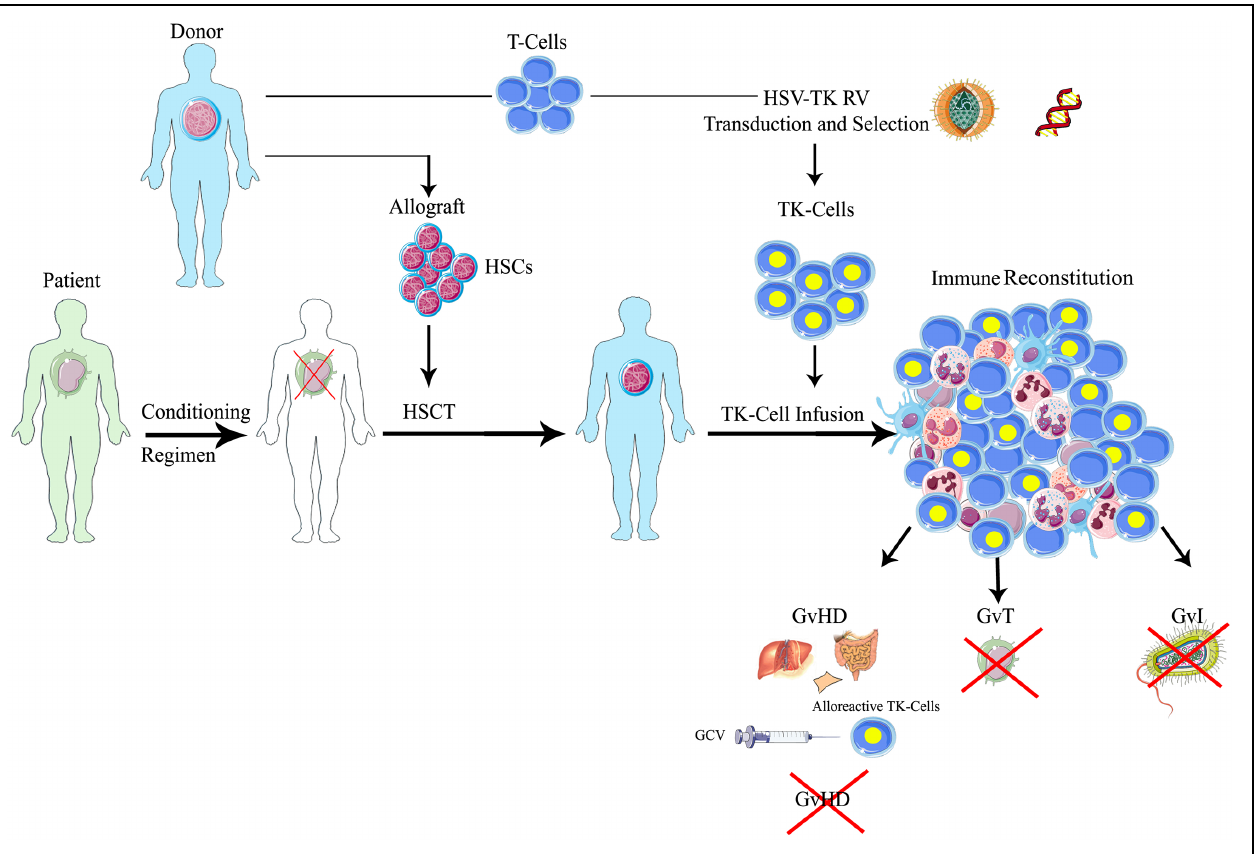
FIGURE 1 | Schematic representation of suicide gene therapy in allogeneic HSCT. Patients affected by hematologic malignancies, after a myeloablative conditioning regimen, receive allogeneic HSCT with CD34-selected donor’s HSCs, followed by the infusion of HSV-TK gene modified donor lymphocytes. Through the ex vivo transfer of the HSV-TK suicide gene, T lymphocytes harvested from the same donors permanently acquire the sensitivity to a the anti-herpes drug, ganciclovir (GCV): in case of GvHD occurrence, the administration of GCV activates the suicide machinery, leading